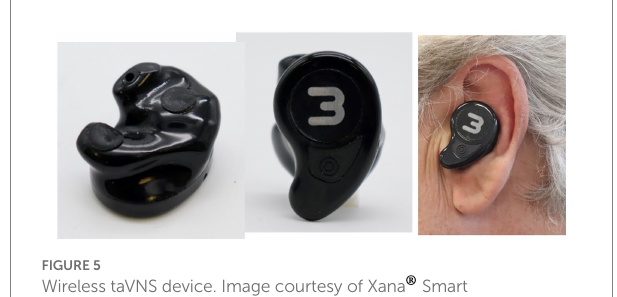
FIGURE 5 Wireless taVNS device. Image courtesy of Xana ® Smart